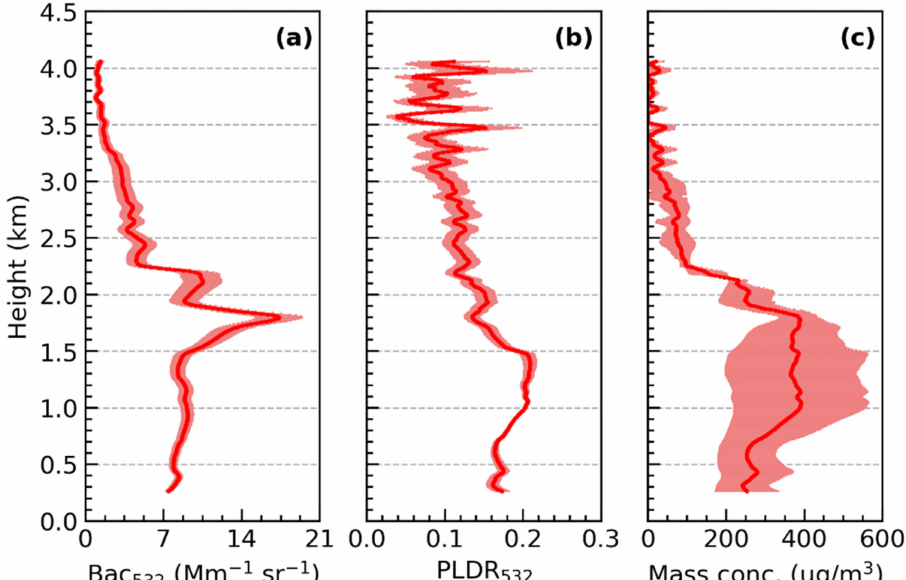
Figure 1. PRL observed ( a ) backscatter coefficient at 532 nm (Bac 532 ), ( b ) PLDR at 532 nm (PLDR 532 ), ( c ) dust mass concentrations at 0:01 on 1 October 2019 (LT). PRL observed profile is the solid red line and the envelope represents the errors at each altitude. Error bars are calculated from the law of error propagation, which primarily depends on the signal-to-noise ratio of the PRL backscatter signal and input parameters given in Table